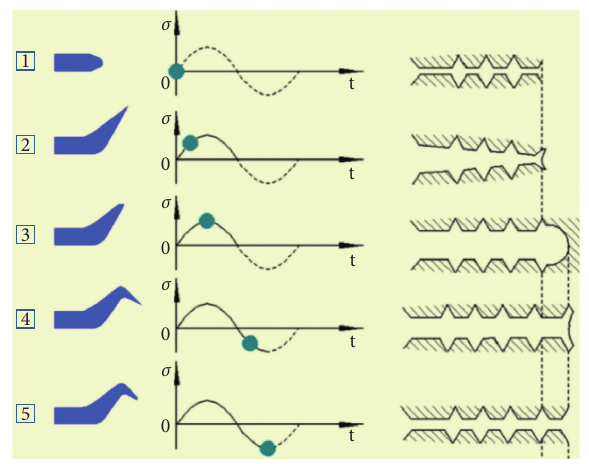
Figure 15: Z-shaped propagation of fatigue